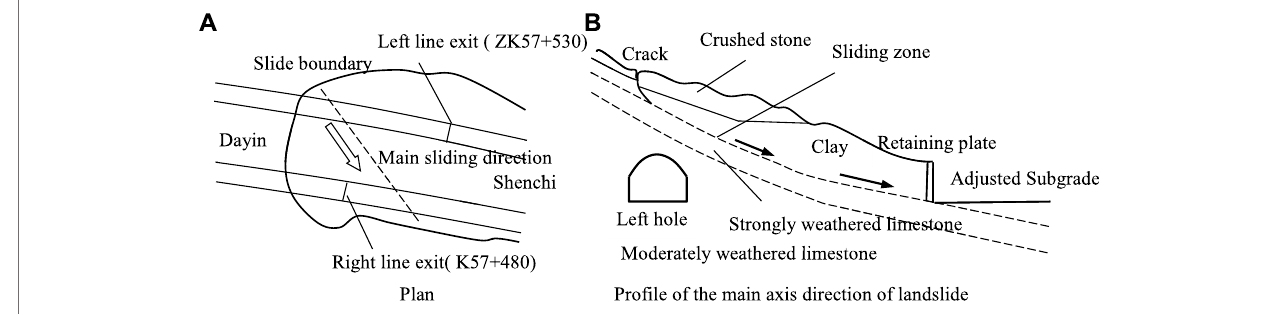
FIGURE 7 | Location relationship between the entrance of the Wenling tunnel and landslide.